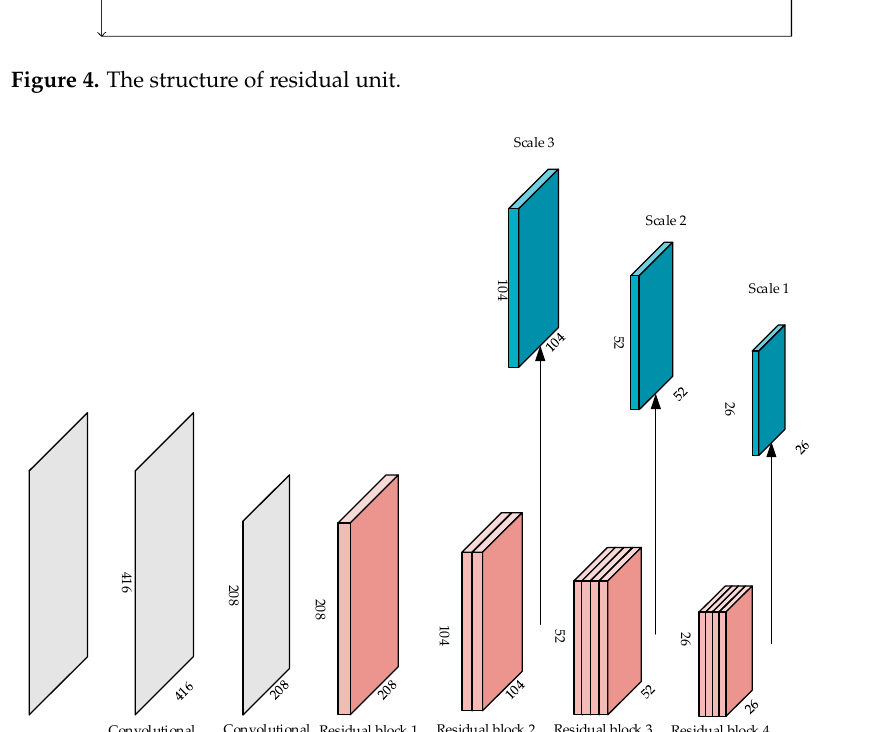
Figure 5. The structure of feature extraction network.